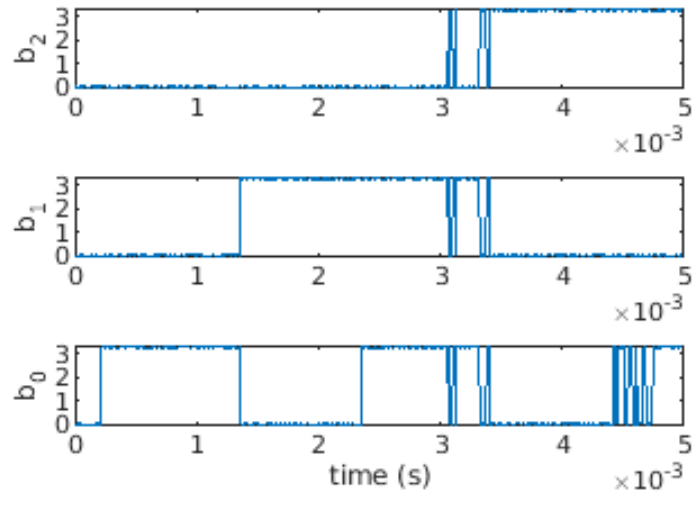
Figure 11. Three least significant bits of the counter ( b 0 is the least significant bit) at a specific time. The temporal behavior of the current in these three cases is shown in Figure 12. The currents are clearly nonlinear because of memory: if they were nonlinear due to other effects, then they would be symmetrical, which they are not. In addition, they are showing a dependence on the frequency, as expected for a memristor.